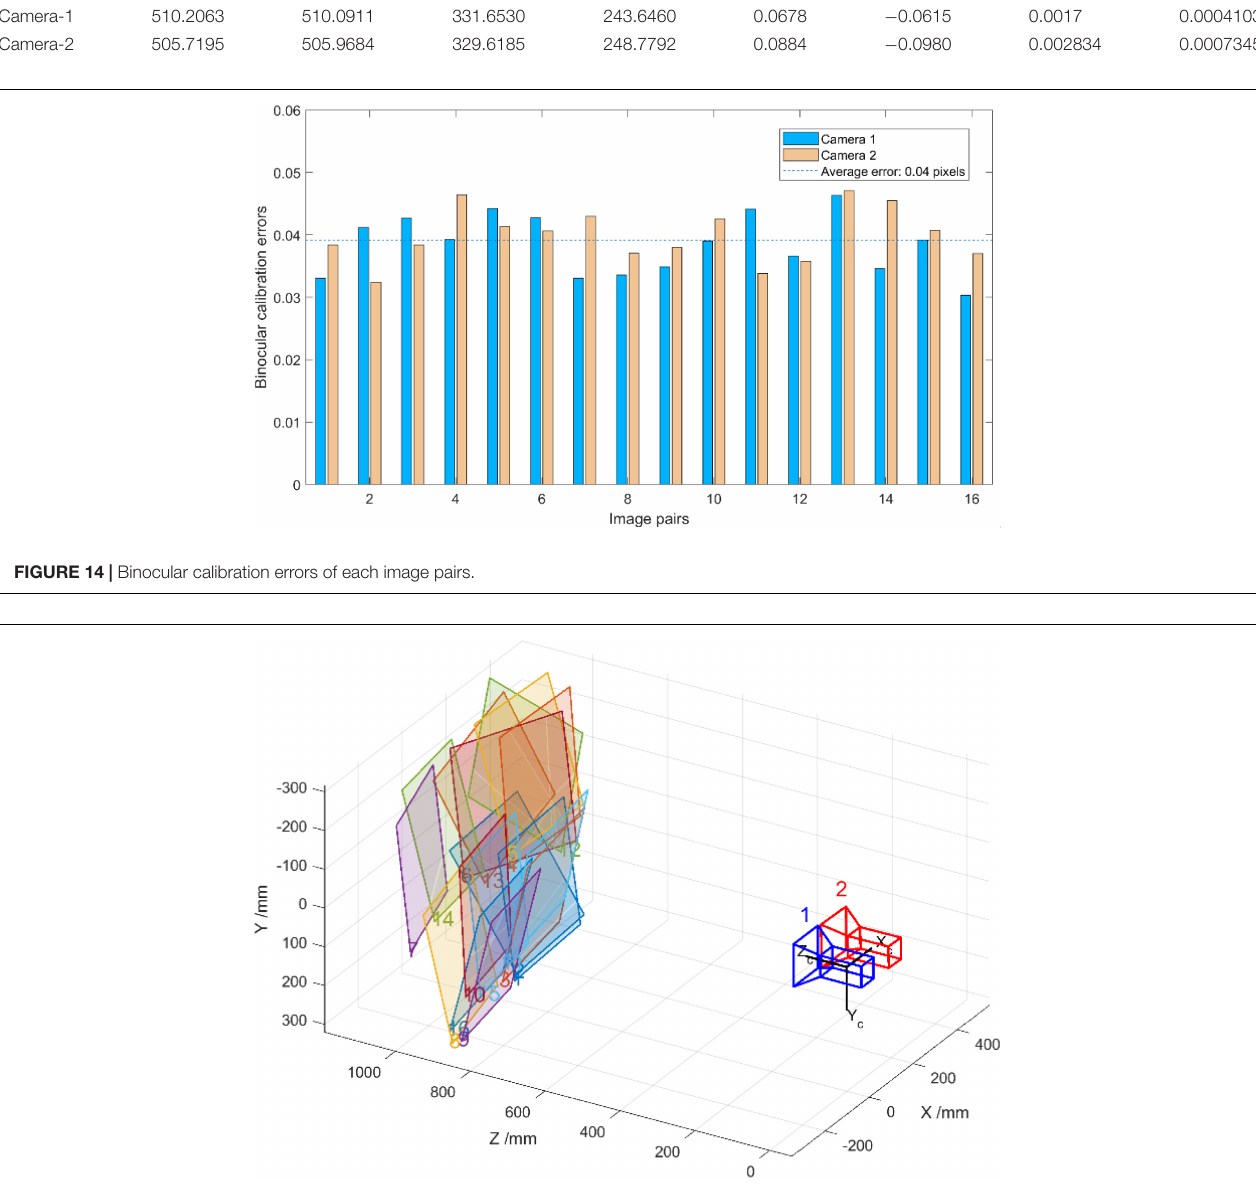
FIGURE 15 | The position and attitude relationship between cameras and calibration chessboard.